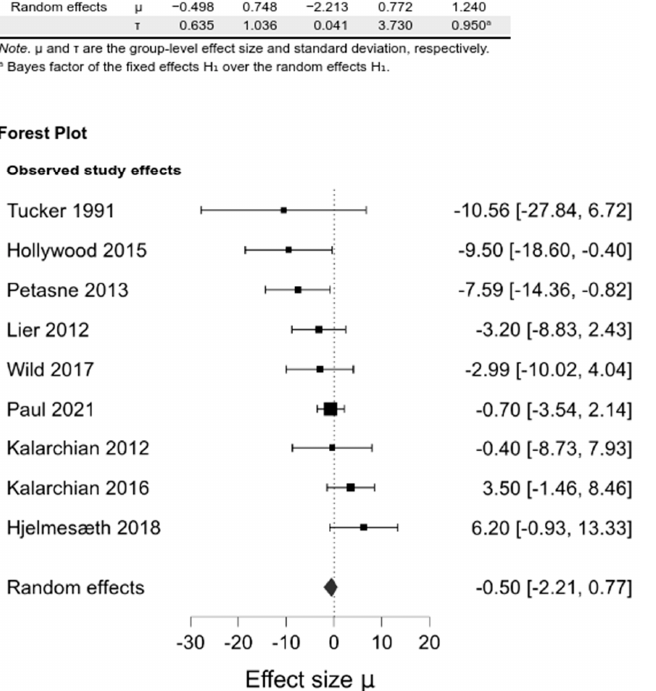
Figure 2. Comparison between psychological intervention versus any control in the change of BMI at the last follow-up. Upon pooling, we did not observe any differences between intervention and control groups in WL at any investigated follow-up (0.14 [ − 1.43, 1.99]; BF 01 = 0.44, − 0.56 [ − 2.2, 0.66]; BF 01 = 1.18, − 0.50 [ − 2.21, 0.77]; BF 01 = 0.24 for 6–12 months, 1–2 year, and the last follow-up, respectively) (Figure 3, Supplementary Materials, Figures S5 and S6, Table S6).